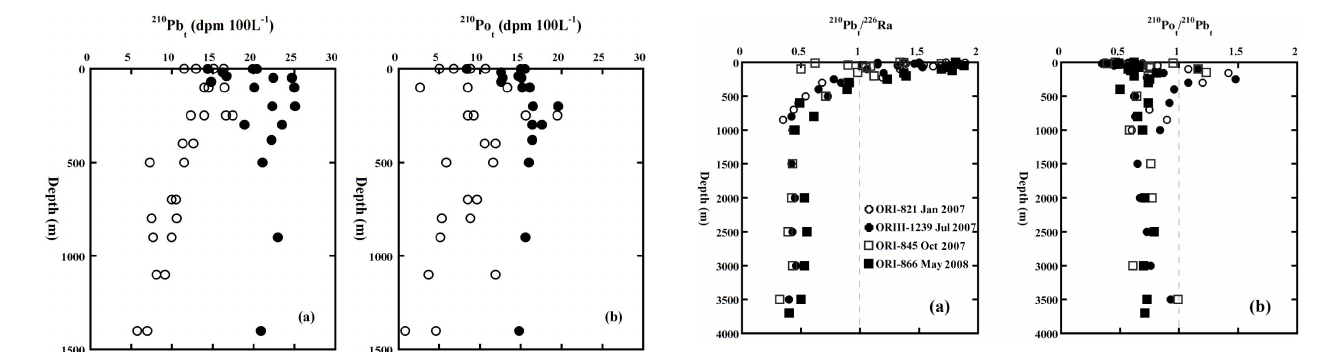
Figure 5. Vertical profiles of 210 Pb t and 210 Po t redrawn from sta- Fig. 5 tions 3 and 7 of Chen and Chung (1997) (open circle) and stations W3 and W5 of Chung and Wu (2005) (solid circle).